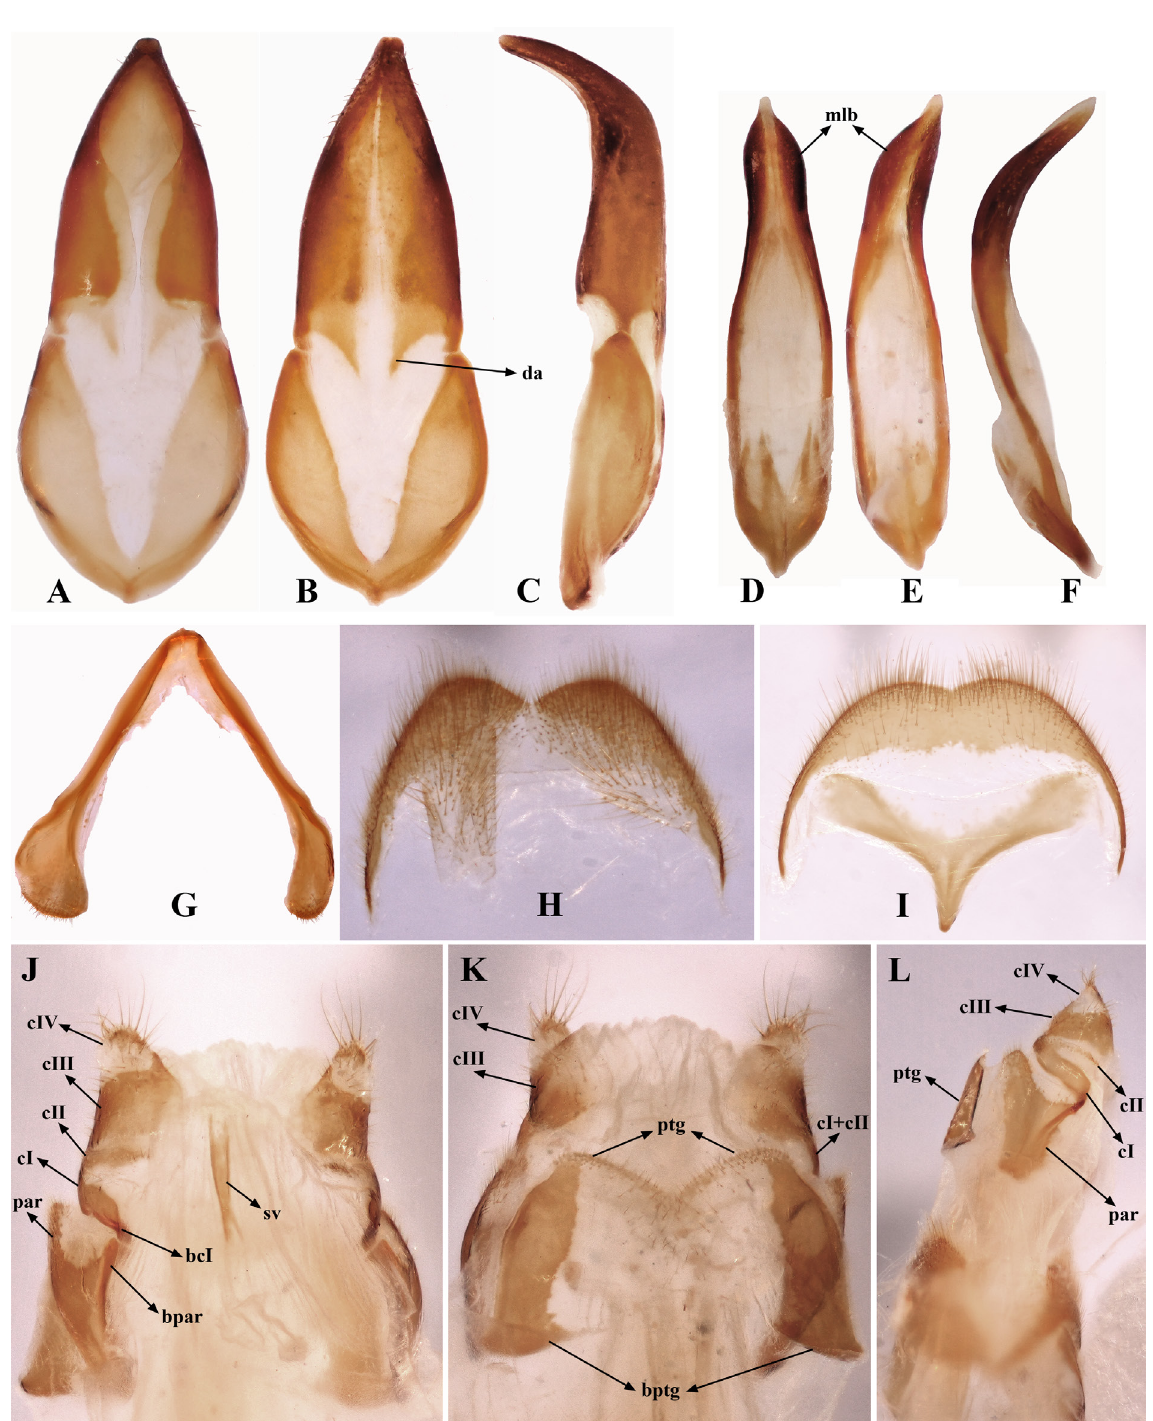
Fig. 17. Dietomorpha pardalis Kühnelt, 1957, genitalia (ZIN). A . Tegmen of aedeagus, ventrally. B . Ditto, dorsally. C . Ditto, laterally. D . Median lobe, ventrally. E . Ditto, dorsally. F . Ditto, laterally. G . Spiculum gastrale. H . ♂, inner sternite VIII. I . ♀, inner sternite VIII and spiculum ventrale. J . Ovipositor, ventrally. K . Ditto, dorsally. L . Ditto, laterally. Not to scale. Abbreviations: see Material and